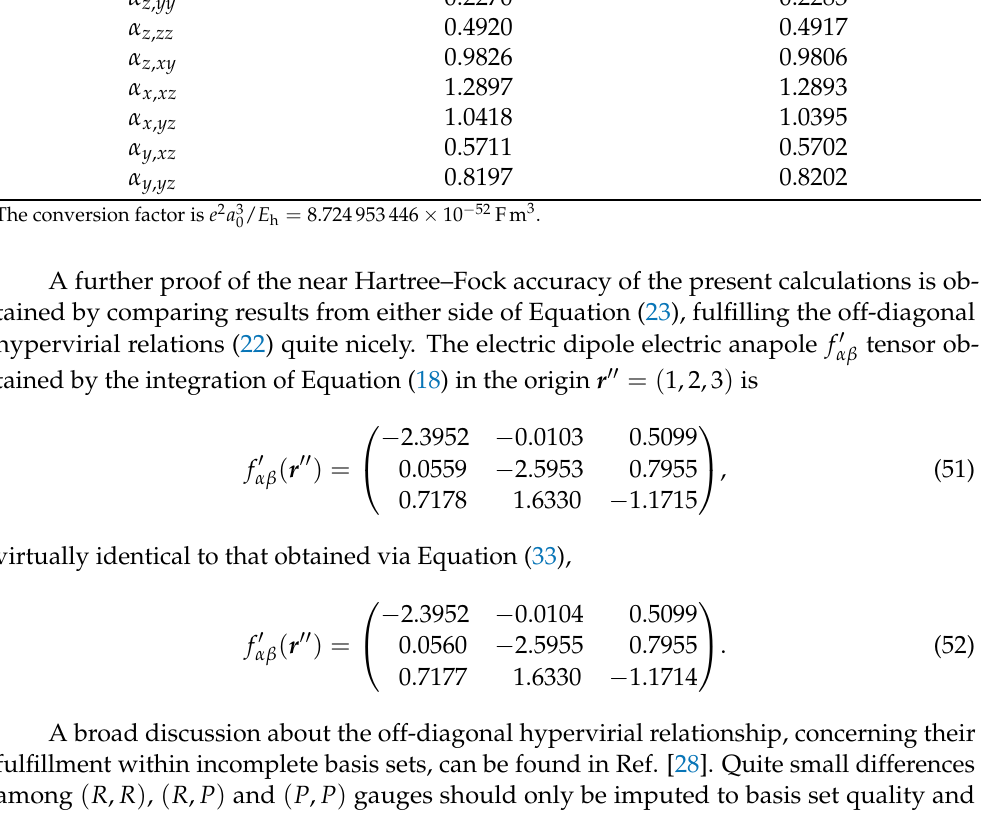
Table 2. Mixed electric dipole-electric quadrupole polarizability within ( R ) and ( P ) formalisms, in atomic units. R P α z , xx 0.9771 0.9768 α z , yy